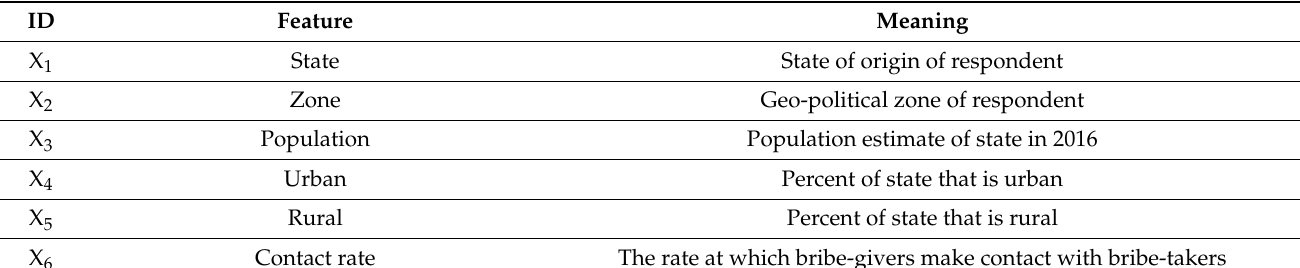
Table 2. Variables and